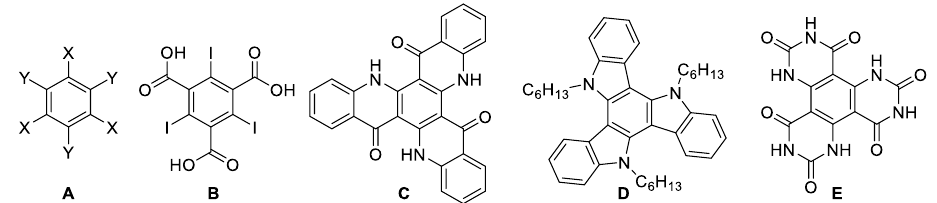
Figure 1. Generic structure of C 3 -symmetric benzenes ( A ), 2,4,6-triiodobenzene-1,3,5-tricarboxylic acid ( B ), [34] two prominent C 3h -symmetric disk-like structures triquinolonobenzene (TQB) ( C ) [9] and 5,10,15-trihexyl-10,15-dihydro-5H-diindolo [3,2-a:3 ’ ,2 ’ -c] carbazole ( D ); precursor dipyrimido [4,5-f:4 ’ ,5 ’ -h] quinazoline-2,4,6,8,10,12¬(1H,3H,5H,7H,-9H,11H)-hexone ( E ) [35].